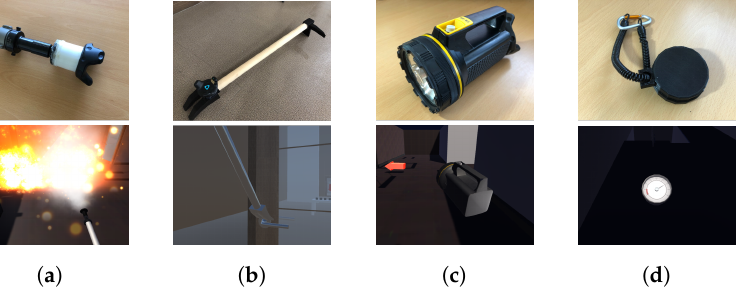
Figure 3. Four real firefighting tools developed in this study: ( a ) fire hose; ( b ) fire axe; ( c ) flashlight; ( d ) air pressure